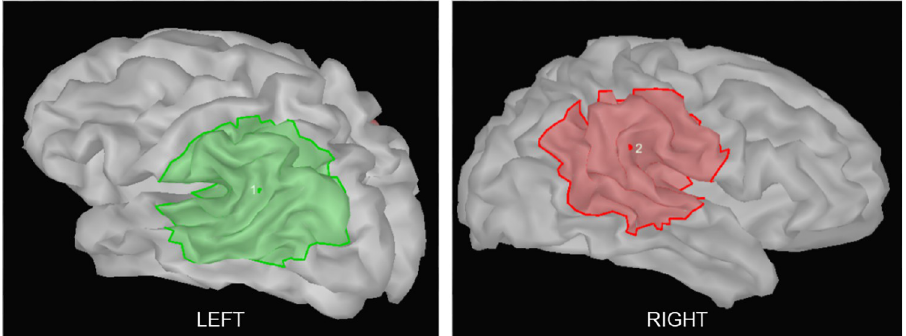
Fig 7. Regions of interest (ROIs) demarcated based on the results of time-frequency analysis for source space. The left ROI encompassed the occipito-temporal region in the left hemisphere that showed significant alpha desynchronisation associated with object recognition and the right ROI included the homologous region in the right hemisphere.